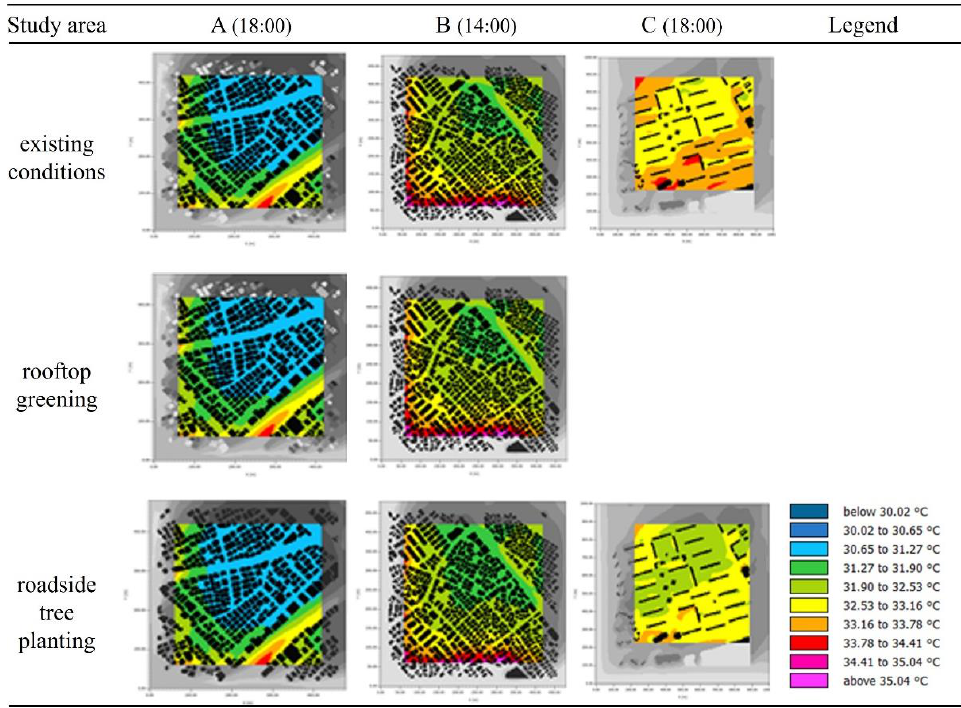
Figure 10. Results of the Envi-met simulation.